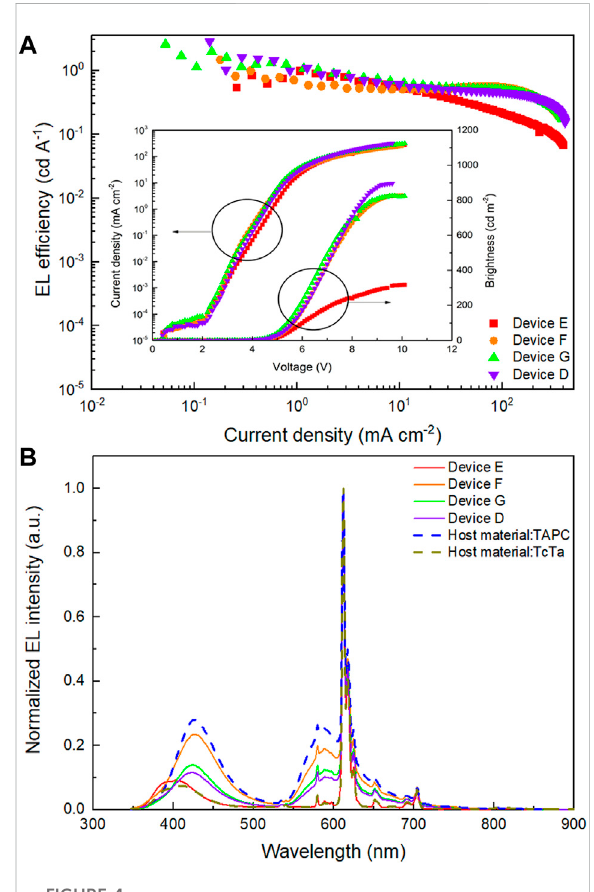
FIGURE 4 (A) EL ef fi ciency-current density ( η -J ) characteristics of devices E, F, G, and D. Inset: current density-brightness-voltage ( J-B-V ) characteristics of devices E, F, G, and D. (B) Normalized EL spectra of devices E, F, G, and D and devices possessing host material only TAPC or TcTa operating at 10 mA cm − 2